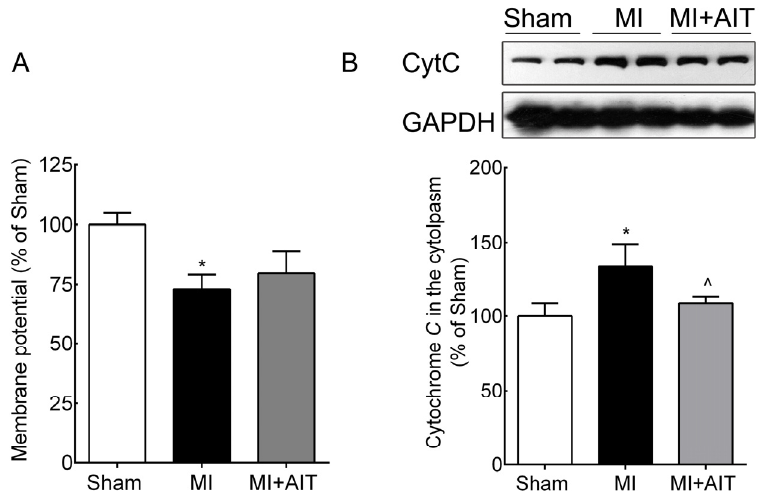
Figure 2. Changes in mitochondrial membrane potential and cytochrome C leakage after MI and AIT intervention. After 8 weeks, the rats were killed, and mitochondrial membrane potential and cytoplasmic cytochrome C levels were assessed. ( A ) Mitochondrial membrane potential; ( B ) cytochrome C (Top: Western blot images; bottom: statistical